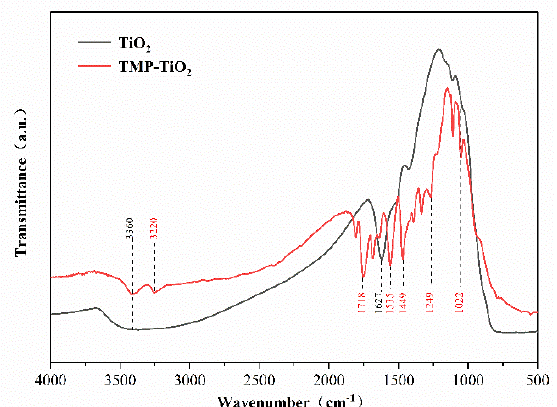
Figure 2. Fourier transform infrared (FTIR) of unmodified TiO 2 and trimesoyl chloride ‐ melamine copolymer (TMP) ‐ TiO 2.